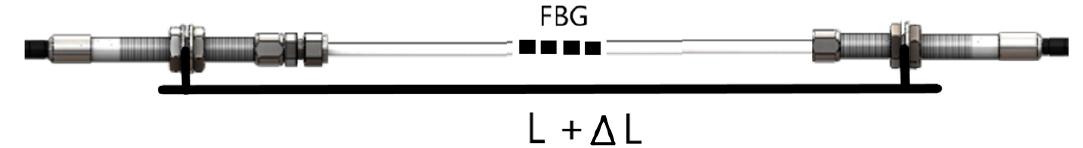
Figure 1. The fiber Bragg grating (FBG) strain sensor.